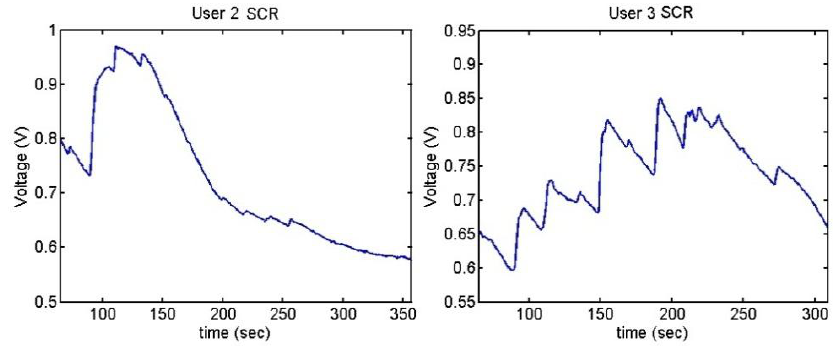
Figure 33. Skin response of users 2 and 3 from Sounds Test.